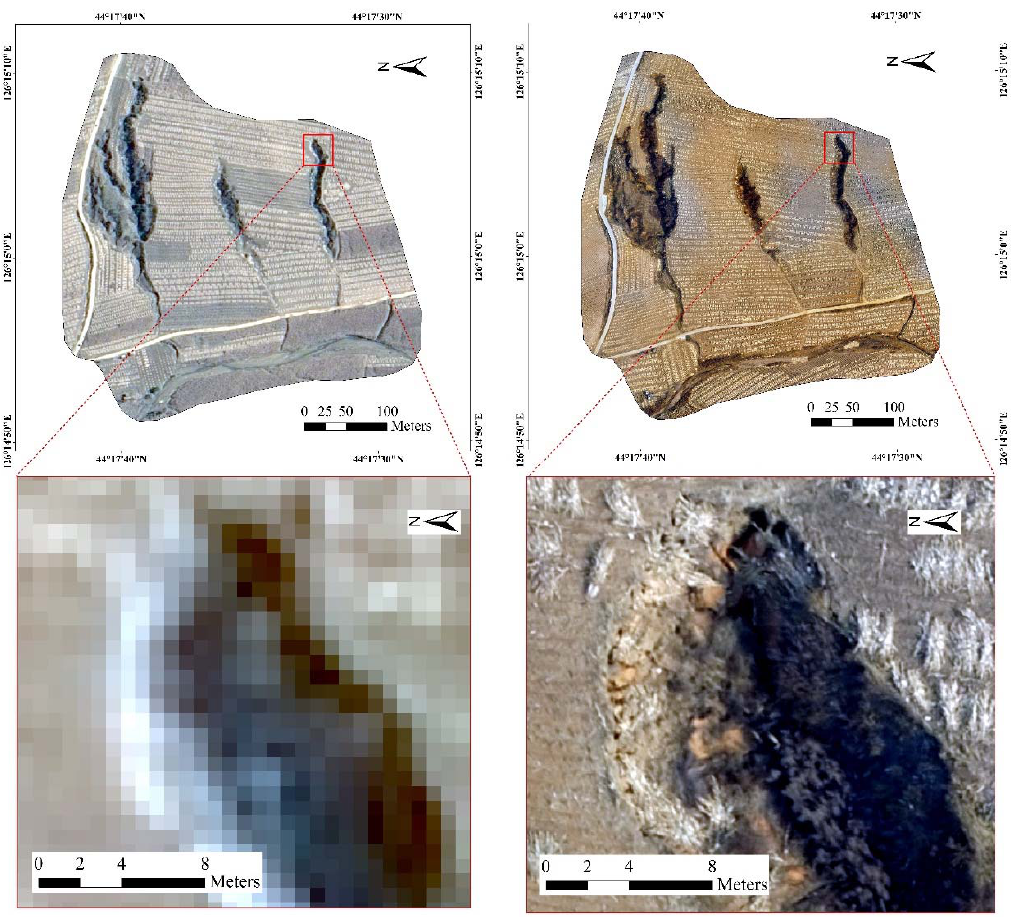
Figure 7. Comparison of the satellite image (12 October 2013; left ) and UAV image (31 October 2015; right ).